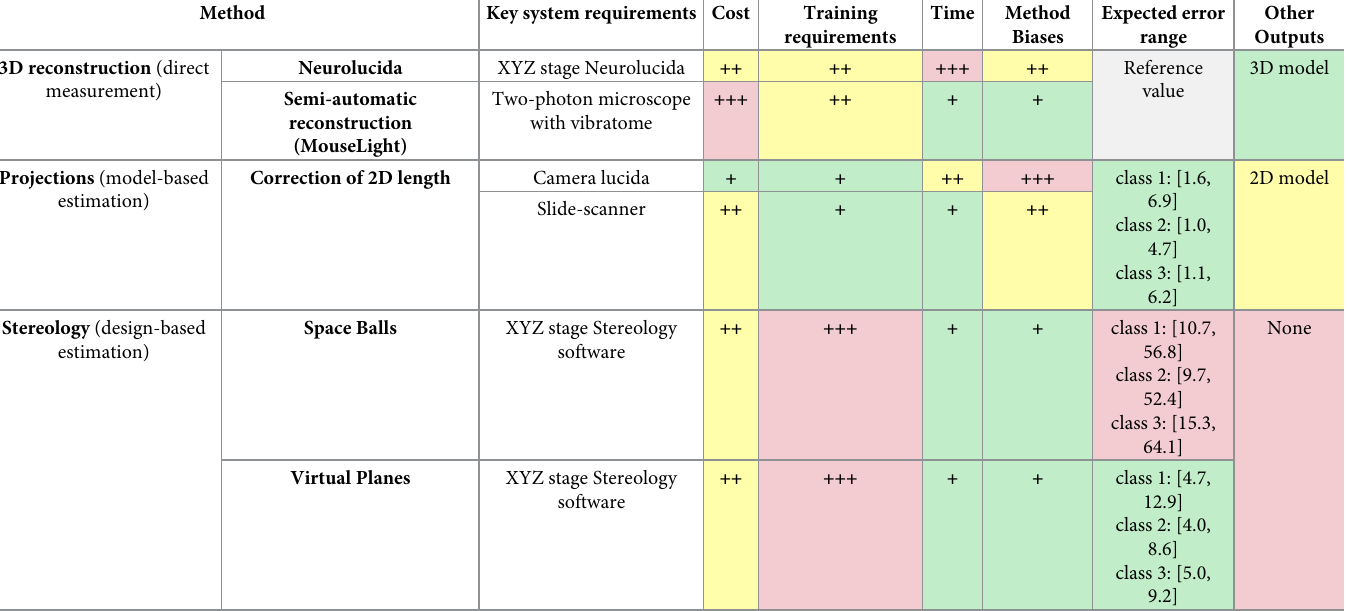
Table 2. Comparison of methodological approaches to measure or estimate axonal length in single